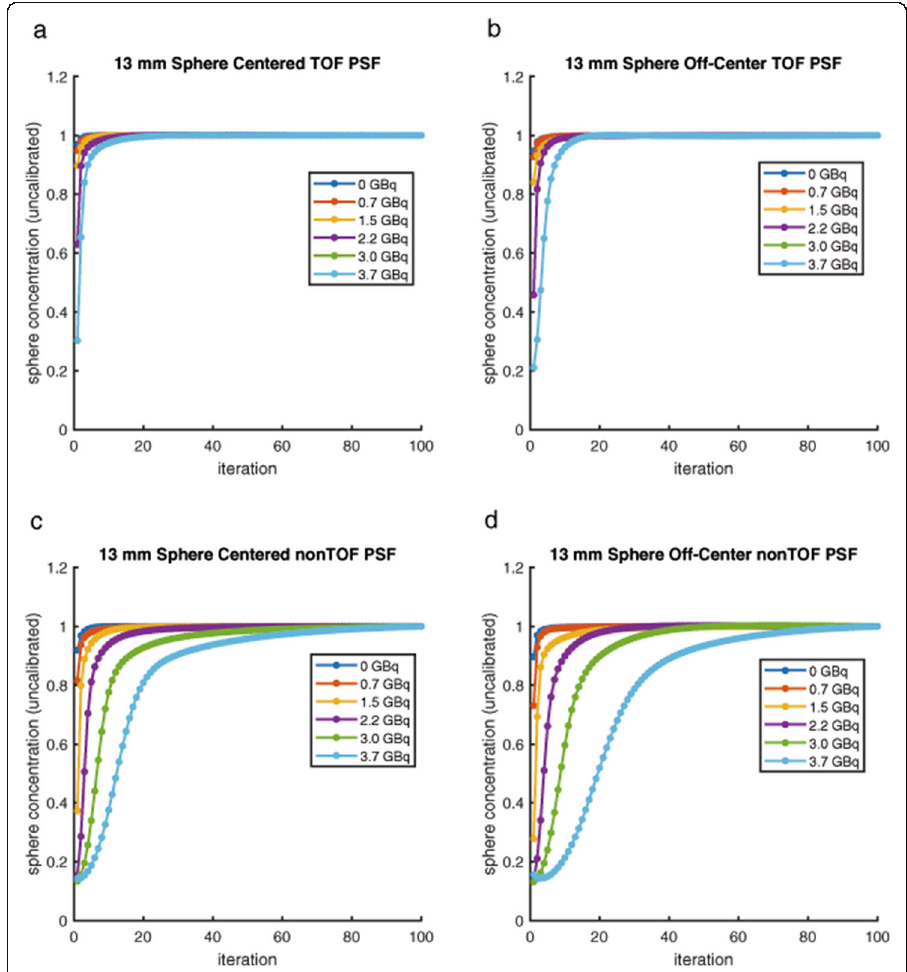
Fig. 5 Normalized mean 124 I concentration measured on the PET image, in a small (3 × 3 × 3 voxel) VOI at the approximate center of the 13-mm-diameter sphere for the centered phantom reconstructed with TOF information ( a ), for the off-center phantom reconstructed with TOF information ( b ), for the centered phantom reconstructed without TOF information ( c ), and for the off-center phantom reconstructed without TOF information ( d ) all shown as a function of the number of iterations. This measurement was done for scans acquired with 0, 0.75, 1.45, 2.23, 2.99, and 3.76 GBq of 131 I in the background. Each curve has been normalized to the concentration seen after 100